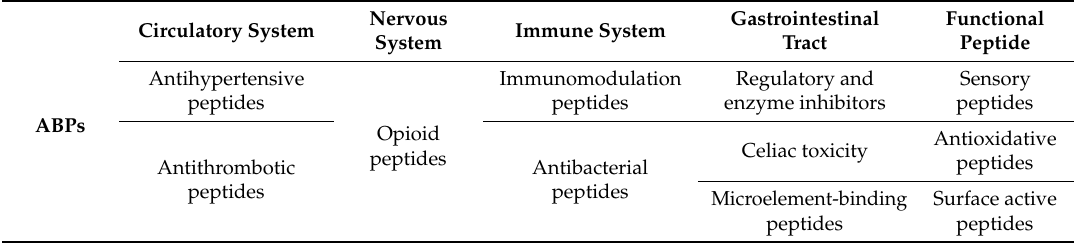
Table 1. Functional activity of milk-derived antibacterial peptides (ABPs) (adopted from